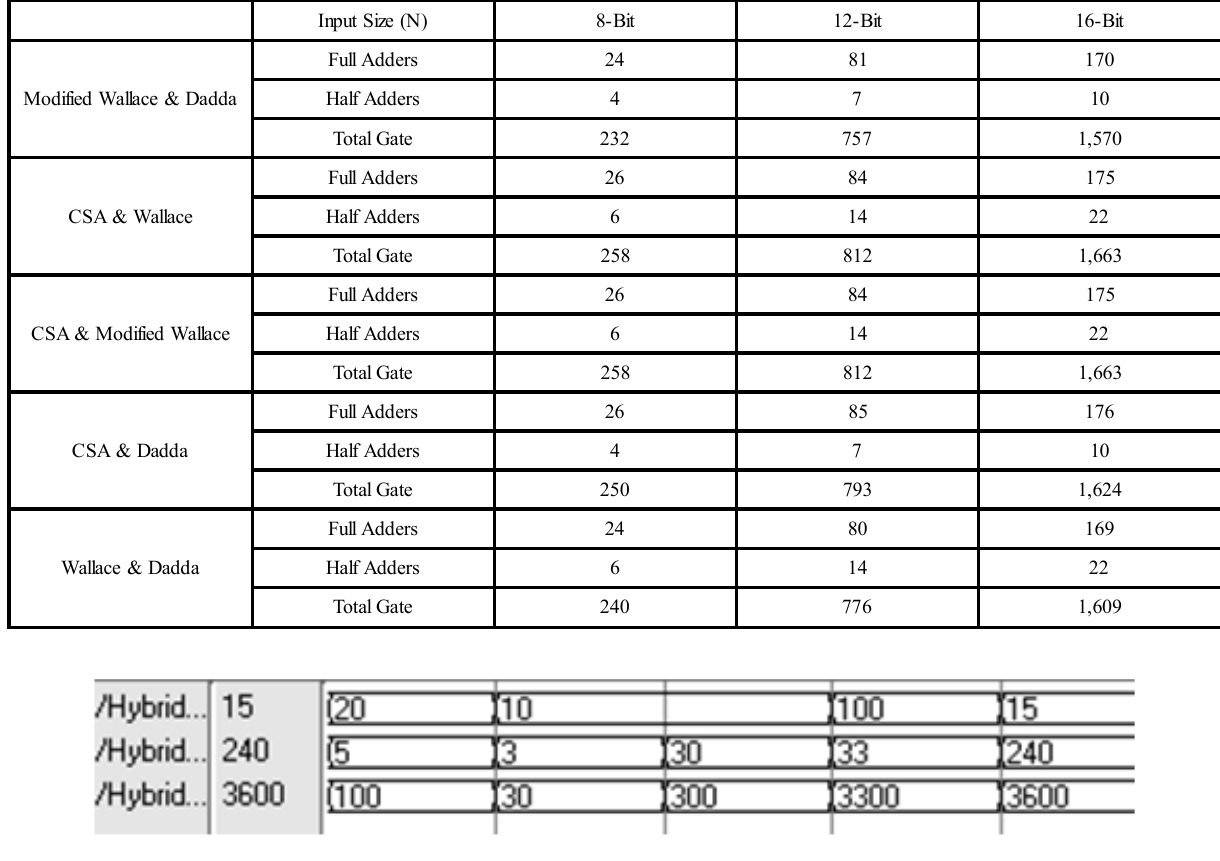
FIG. 8. SIMULATION WAVEFORM OF THE HYBRID OF MODIFIED WALLACE AND DADDA TREE